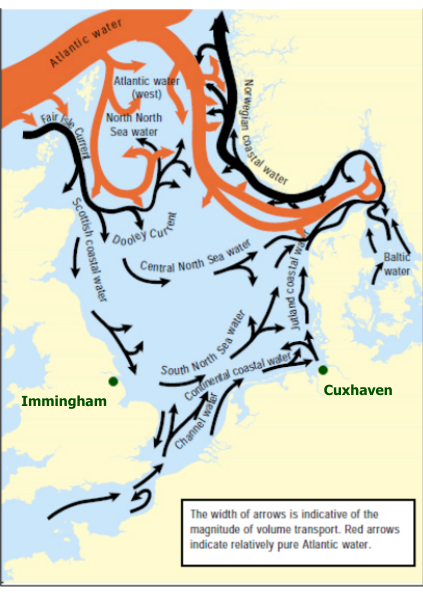
Figure 2. General circulation scheme in the North Sea (from OSPAR (2000); adapted from Turrell,